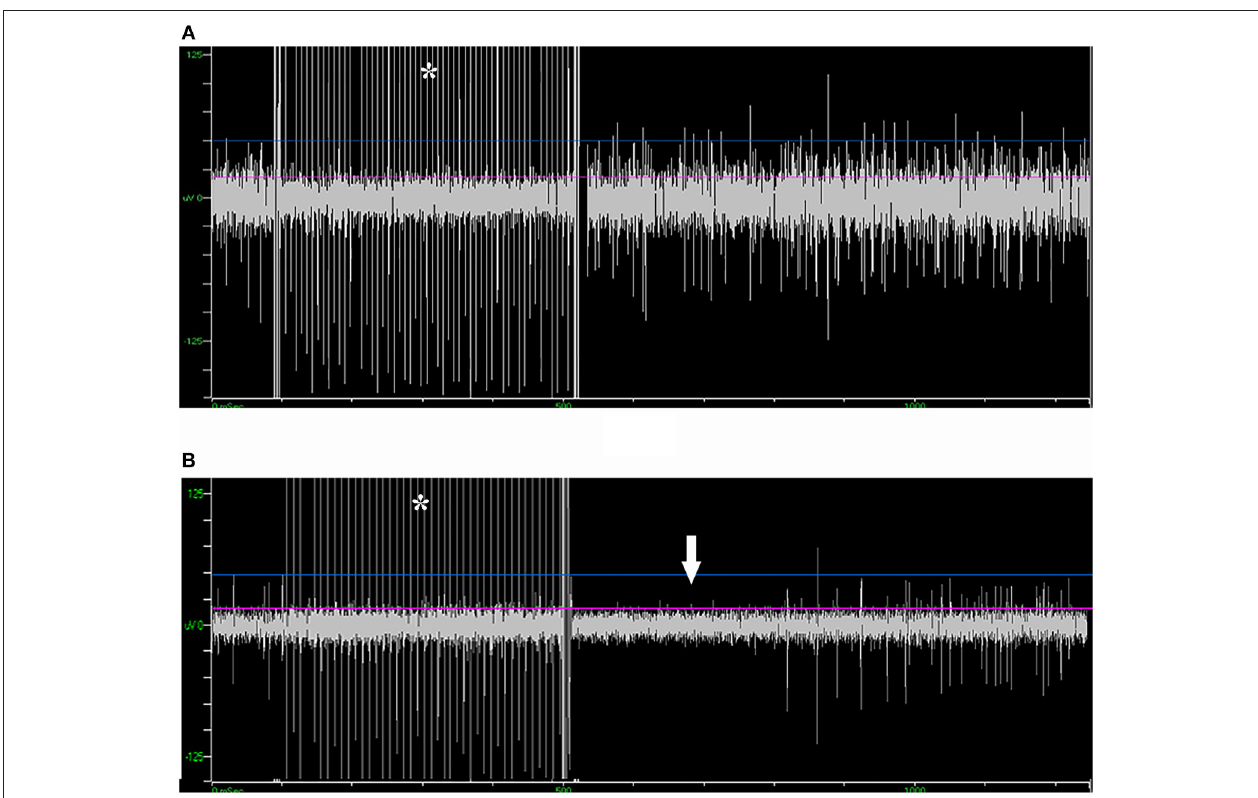
FIGURE 5 | Microstimulation-induced inhibition of neuronal activity in SNr but not in STN. (A) Microstimulation (asterisk) in STN failed to induce inhibition in neuronal activity. (B) Microstimulation induced long inhibition (arrow) in SNr. STN, subthalamic nucleus; SNr, substantia nigra.